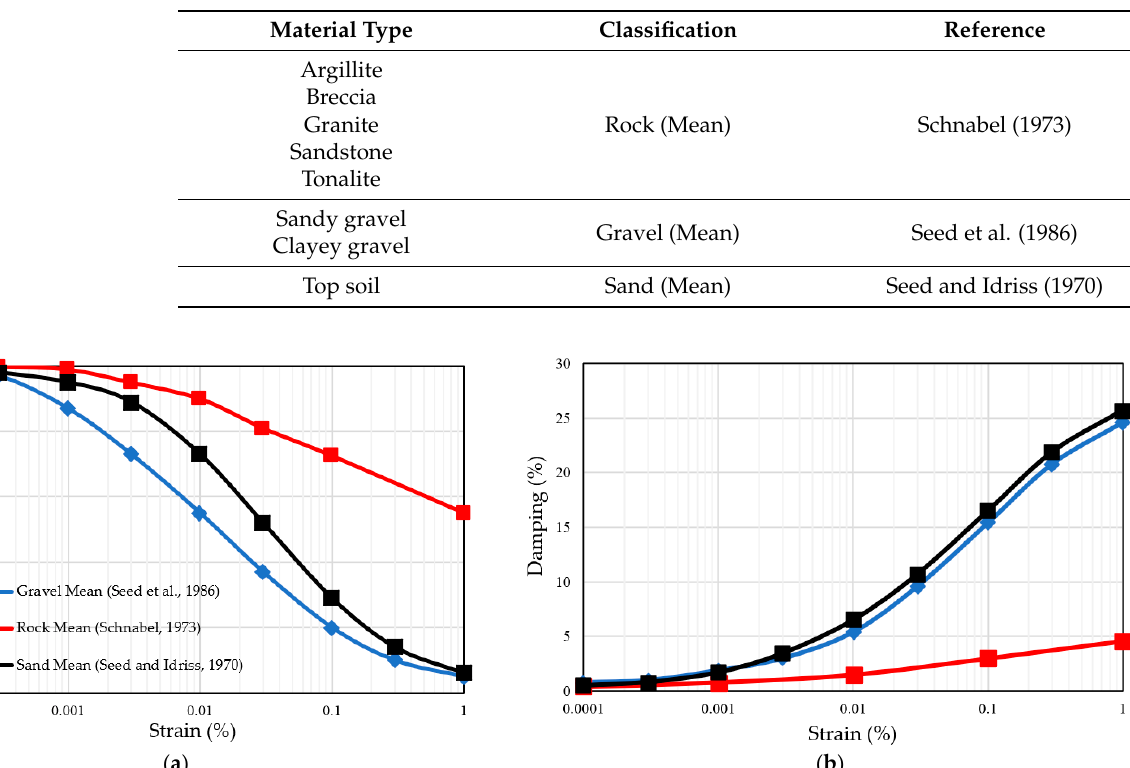
Figure 9. Dynamic soil properties: ( a ) Normalized shear modulus reduction curves; ( b ) damping ratio curves.